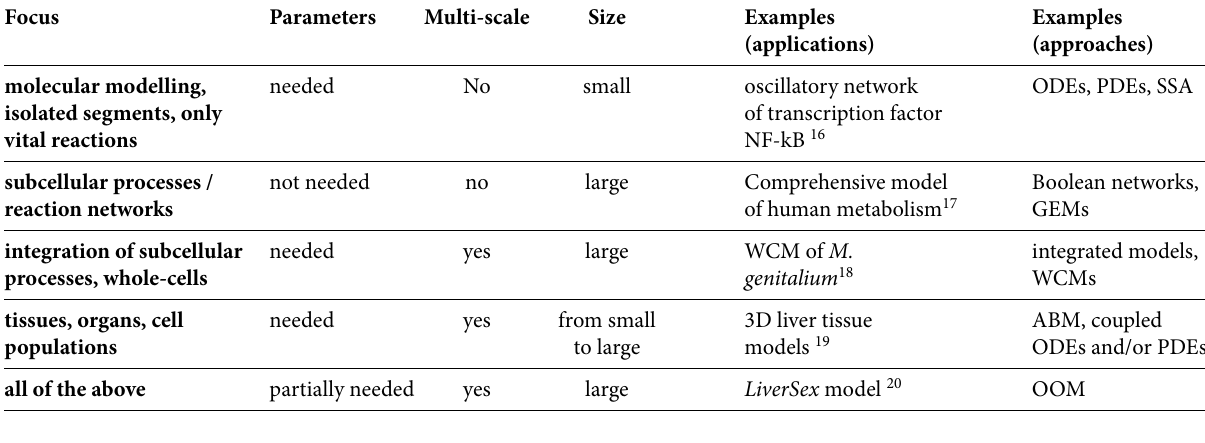
Table 1: Dynamical modelling approaches depend on the focus, the data and the size of the observed (sub)system. Abbreviations: NF-kB – nuclear factor kappa beta, ODEs – ordinary differential equations, PDEs – partial differential equations, SSA – stochastic simulation algorithm, GEMs –